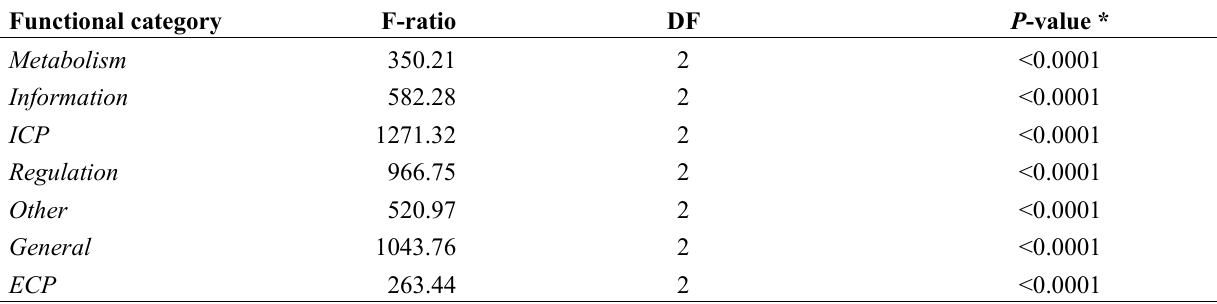
Table S3. Comparison of functional categories across superkingdoms using Welch’s ANOVA.